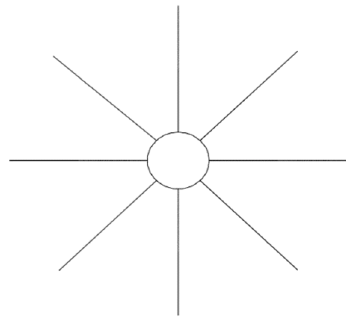
Figure 3. A schematic of the measurement pattern of the cathodic disbondment area of the polyethylene (3PE) coating.